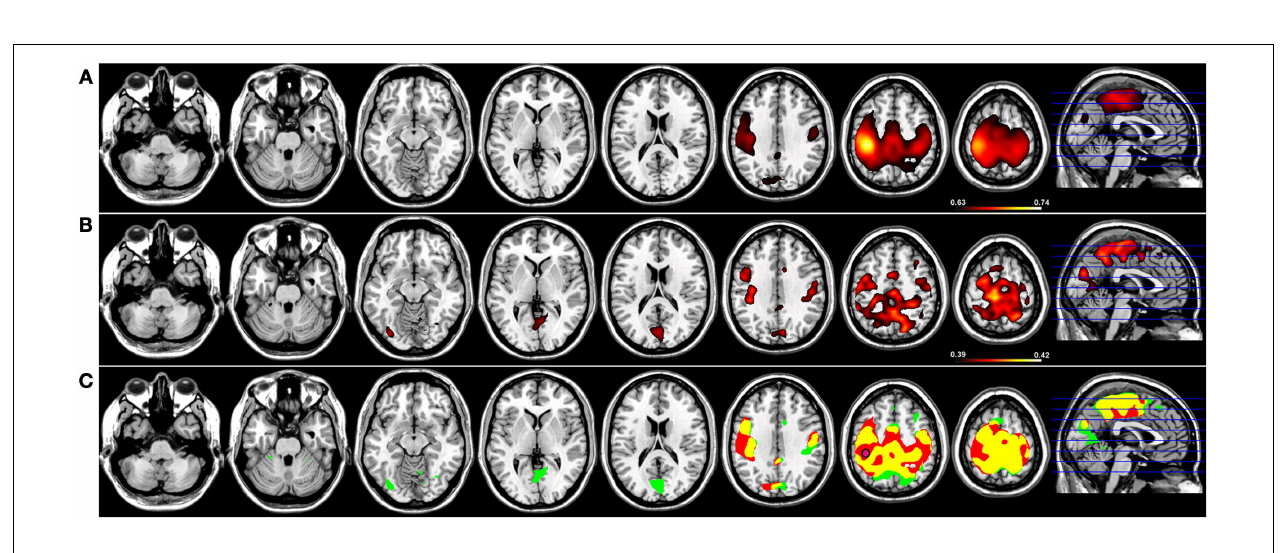
FIGURE 2 | Resting-state functional connectivity maps for a seed placed in left primary motor cortex (M1; pink circle) in 15 healthy control subjects reconstructing the sensorimotor network (SMN) for left M1 . (A) SMN reconstruction using magnitude coherence (Coh).